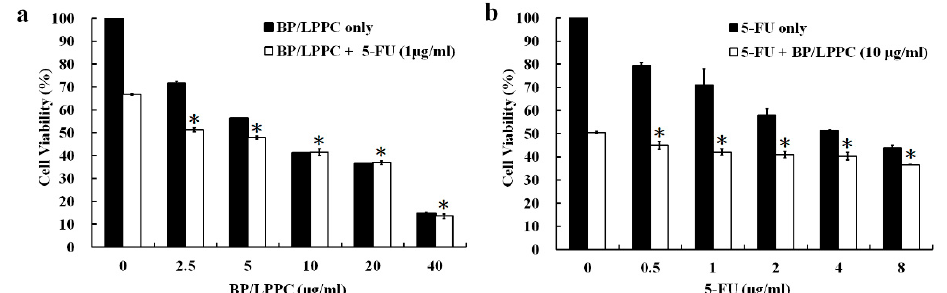
Figure 5. Synergistic e ff ect of BP / LPPC combined with 5-FU. HT-29 cells were treated with ( a ) BP / LPPC (0, 2.5, 5, 10, 20 and 40 µ g / mL) combined with 5-FU (1 µ g / mL) or ( b ) 5-FU (0, 0.5, 1, 2, 4 and 8 µ g / mL) combined with BP / LPPC (10 µ g / mL) for 24 h. * p < 0.05 compared with the control in the drug combination group.